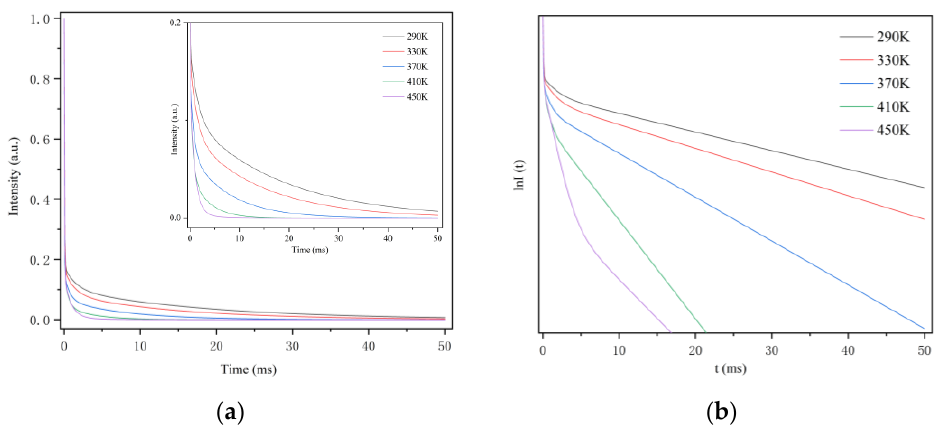
Figure 8. ( a ) The fluorescence afterglow decay curve of CSO:Mn 2+ at different temperatures. ( b ) The relationship between the semi-logarithmic of I and t at different temperatures.